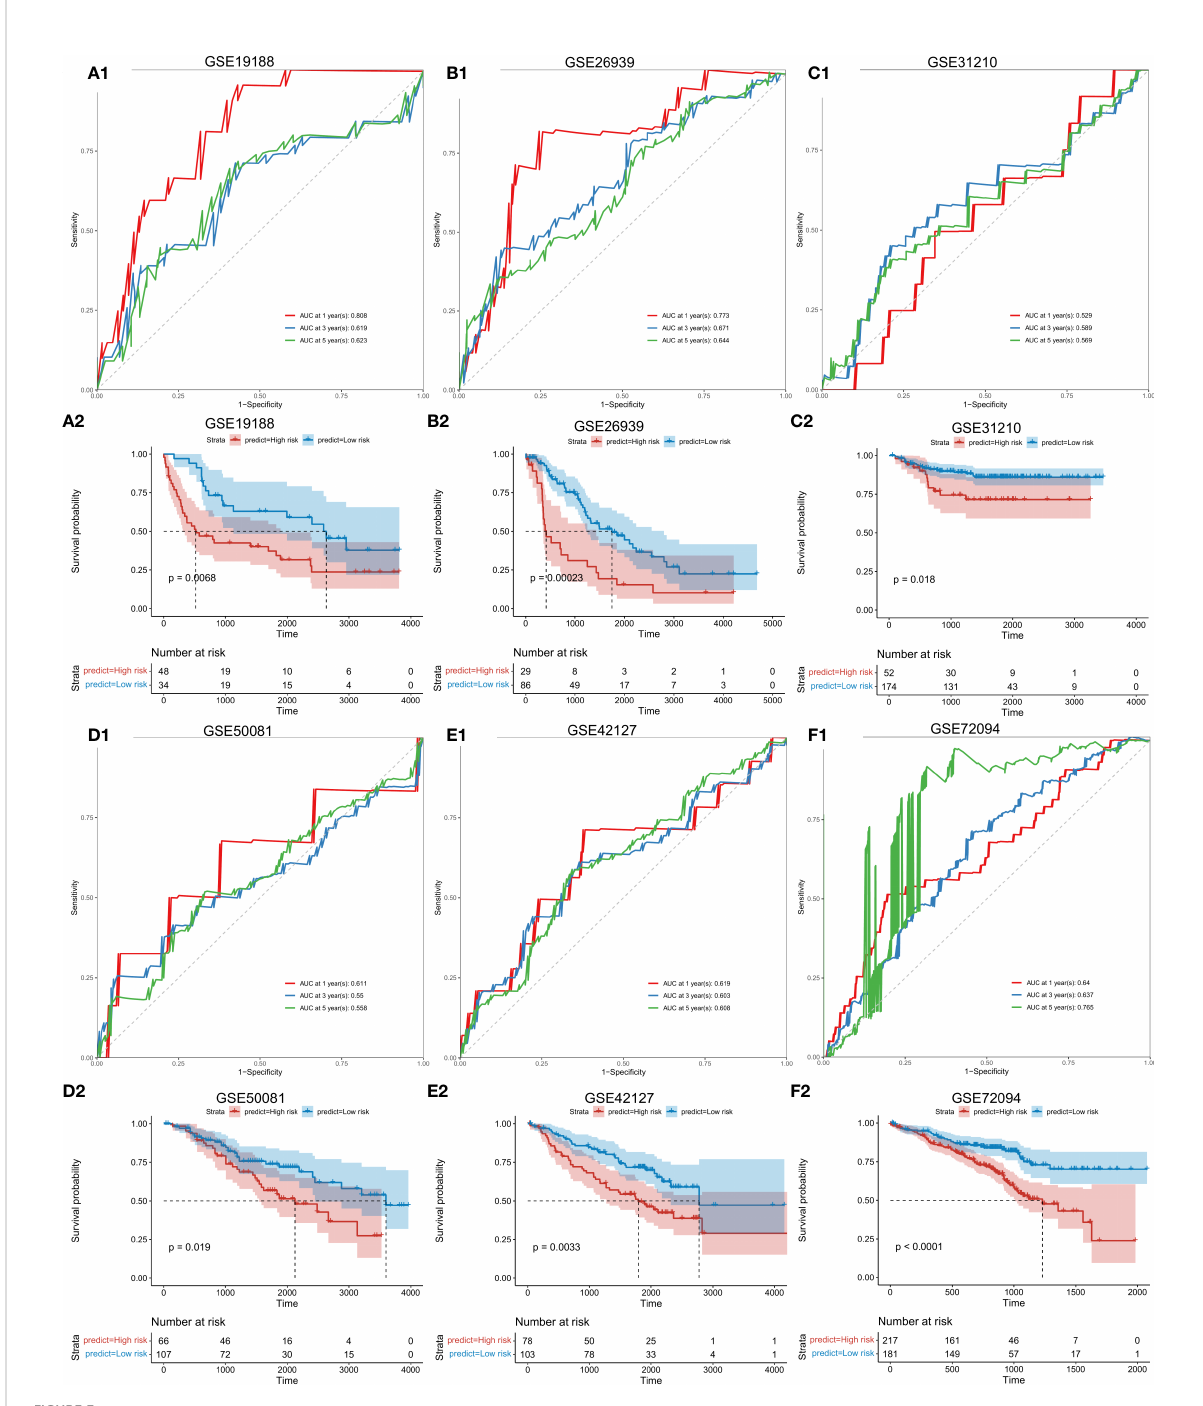
FIGURE 3 Validation of the risk score model with external independent data. A1: Validation (ROC curve) of the risk score model using external independent data GSE19188; A2: survival analysis. B1: Validation (ROC curve) of the risk score model using GSE26939. B2: Survival analysis using GSE26939. C1: Validation (ROC curve) of the risk score model using GSE31210. C2: Validation (survival analysis) using GSE31210. D1: Validation results (ROC curve) of the risk score model using GSE50081. D2: (survival analysis) of the risk score model using GSE50081. E1: Validation results (ROC curve) of the risk score model using GSE42127. E2: survival analysis using E42127. F1: Validation (ROC curve) of the risk score model using GSE72094. F2: Survival analysis using GSE72094. Abscissa axis: survival time; Ordinate axis: survival probability. Colors: different risk